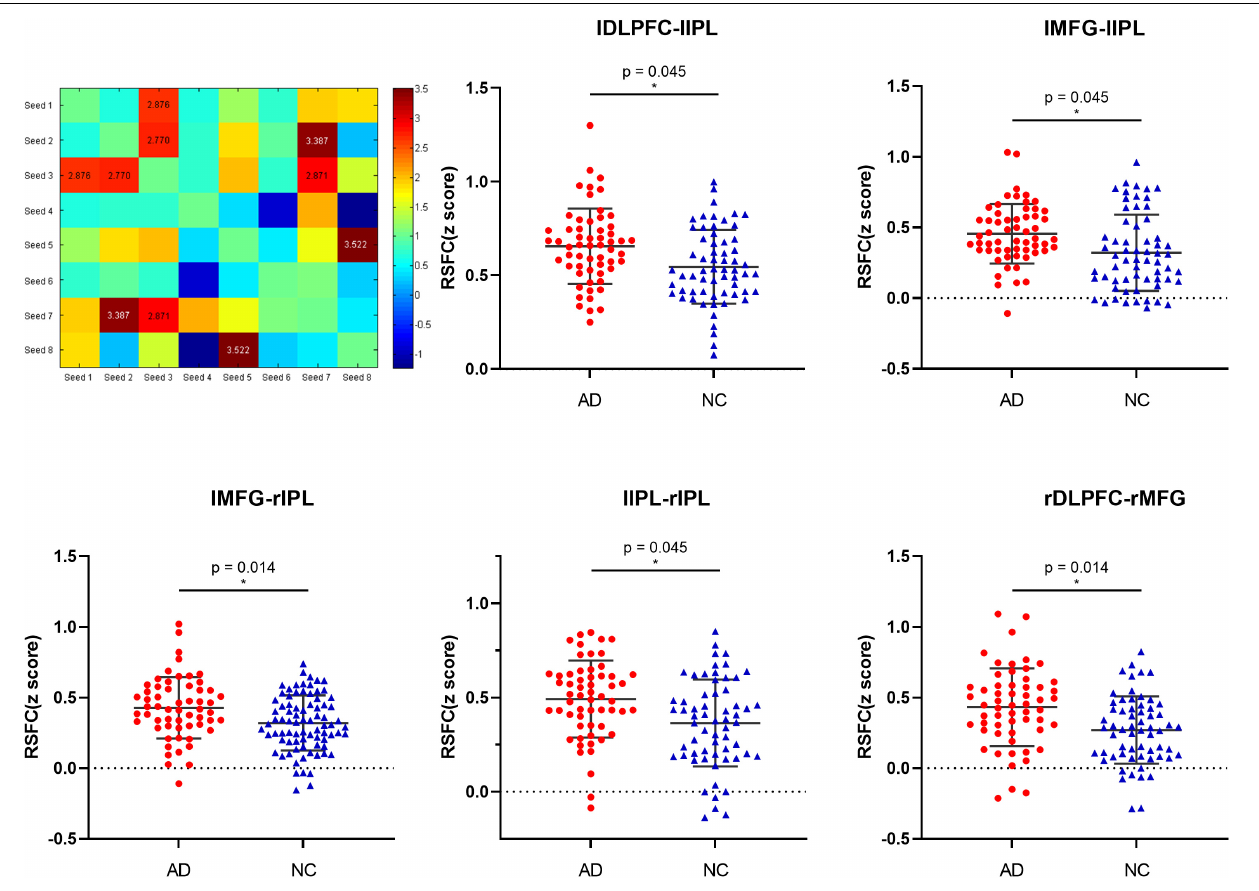
FIGURE 2 | The differences in resting-state functional connectivity (mean Z -value) within the bilateral ECN seeds between the AD patients and normal controls.